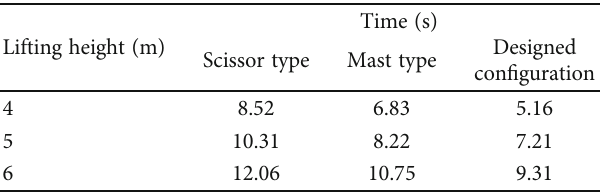
Figure 16: Frequency and deformation of aerial working platform at four postures. Table 1: Comparison of the time spent of aerial working platforms with the same